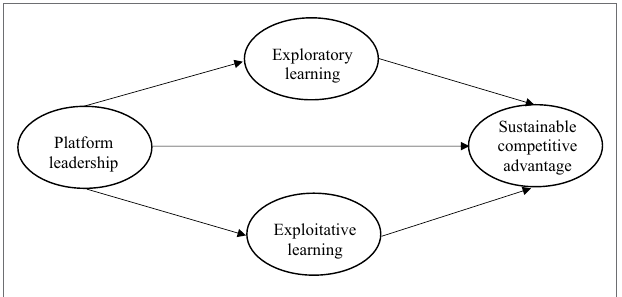
FIGURE 1 | Research framework.